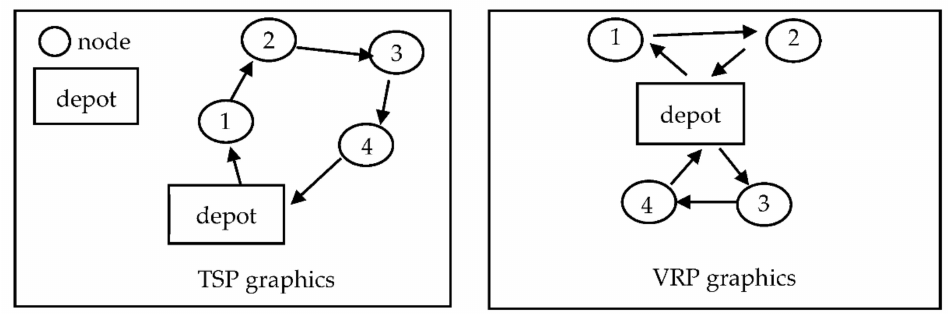
Figure 1. Difference between TSP and VRP.